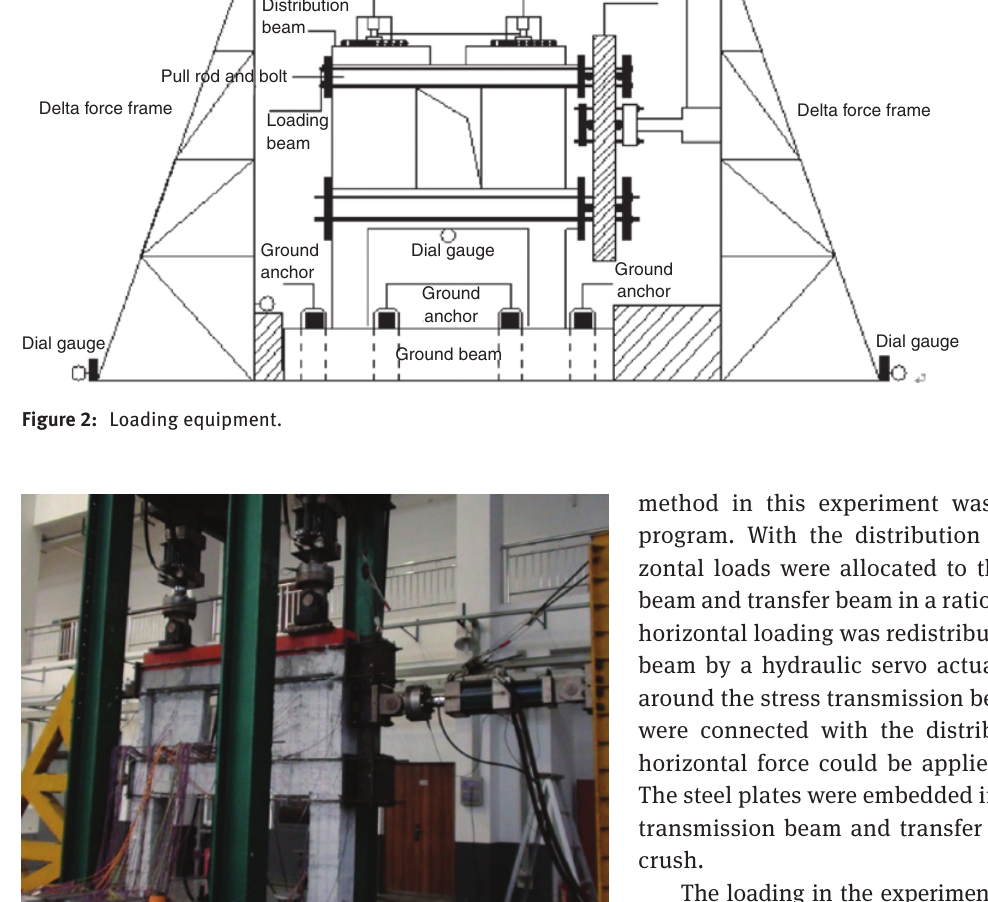
were placed on top of the stress transmission beam. The vertical loading applied by the two hydraulic jacks would transmit to the stress transmission beam through steel distribution beams and assigned to the components. The hydraulic jacks were placed just above the centrum of the short-leg shear wall. In order to enable the specimen to freely horizontally move under the horizontal load, the rolling bearings were set between the vertical hydraulic jack and the steel